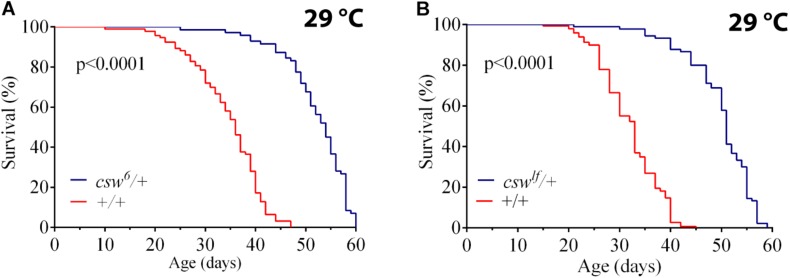
Loss-of-function (LOF) csw mutations extend life span. Effect of reducing the tyrosine phosphatase CSW on life span at 29°C. (A,B) Life span was extended by the classical csw LOF mutations csw6/+ (A) and cswlf/+ (B) compared with a control group (+/+). All the three genotypes share the same genetic background of w1118. Log-rank test. The number of animals was n = 103 to 149, at least from four independent experiments.